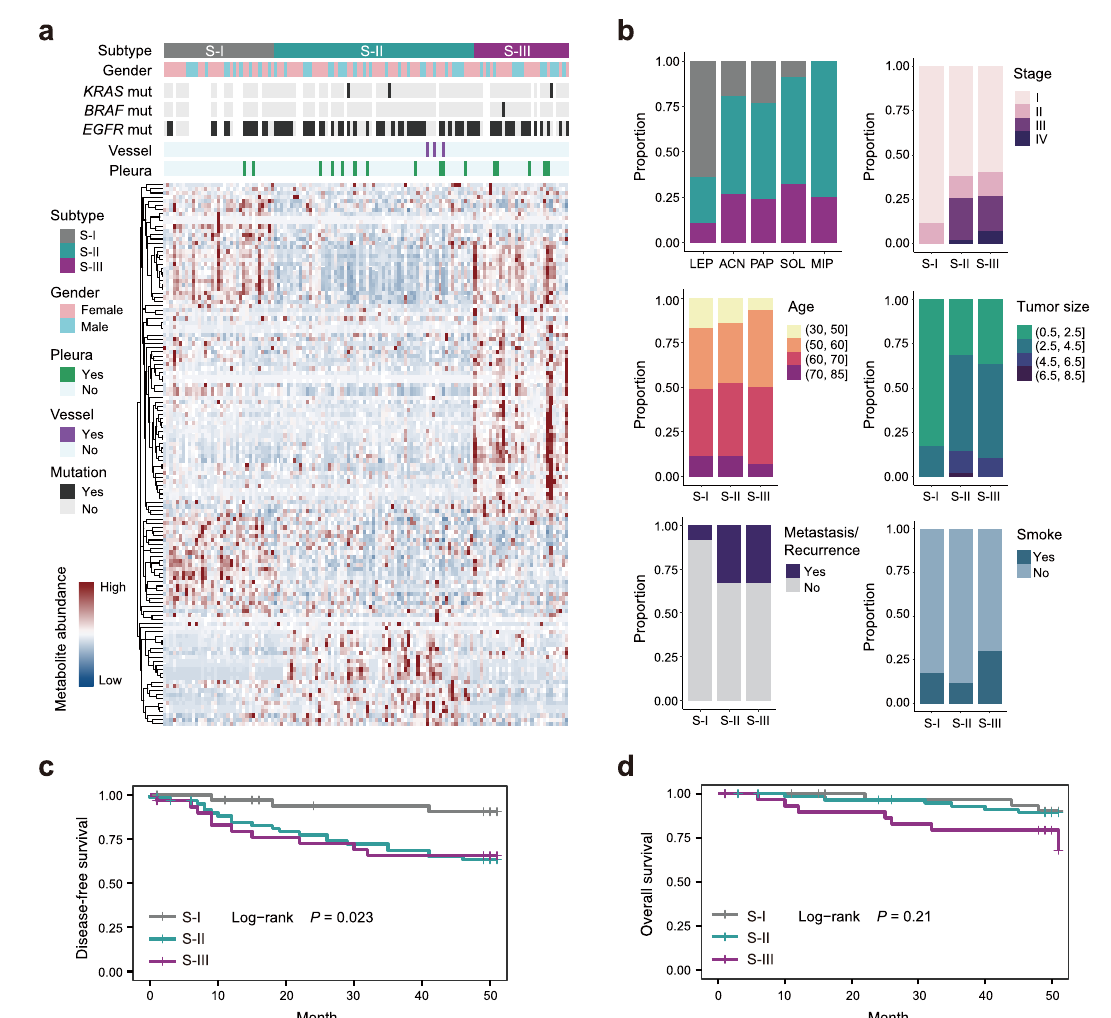
Fig. 4 Metabolic strati fi cation of IAC patients and their clinicopathologic correlations. a Heatmap indicating the relative abundance of metabolites in the identi fi ed three metabolomics subtypes. b Clinical parameters of each metabolic subtype were presented. Fisher ’ s exact test was used. c , d Association of three metabolic subtypes with clinical outcomes including disease-free survival and overall survival in IAC patients. A two-sided log-rank test was